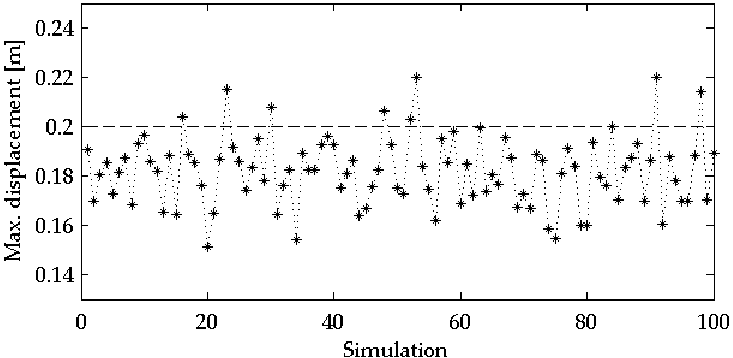
Figure 6. Maximum displacement at the mid-span of the stay cable damped by the viscous damper for the different elements of the sample.